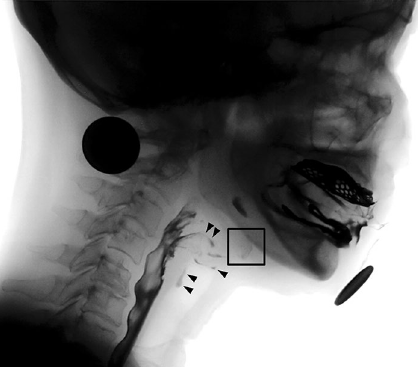
Figure 1. The hyoid bone (black square) observed in the image of videofluoroscopic swallowing study. Liquid bolus was aspirated in the airway (arrow